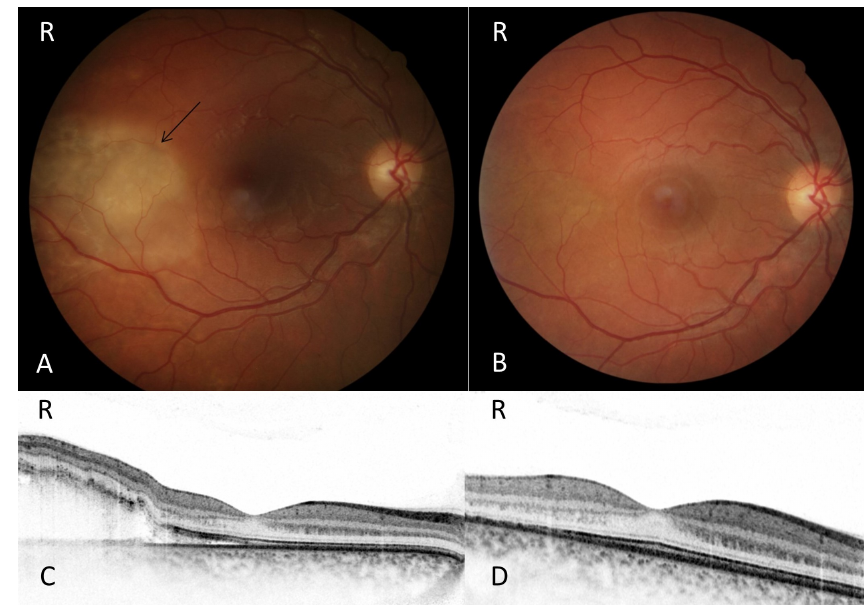
Figure 1: Fundus changes in